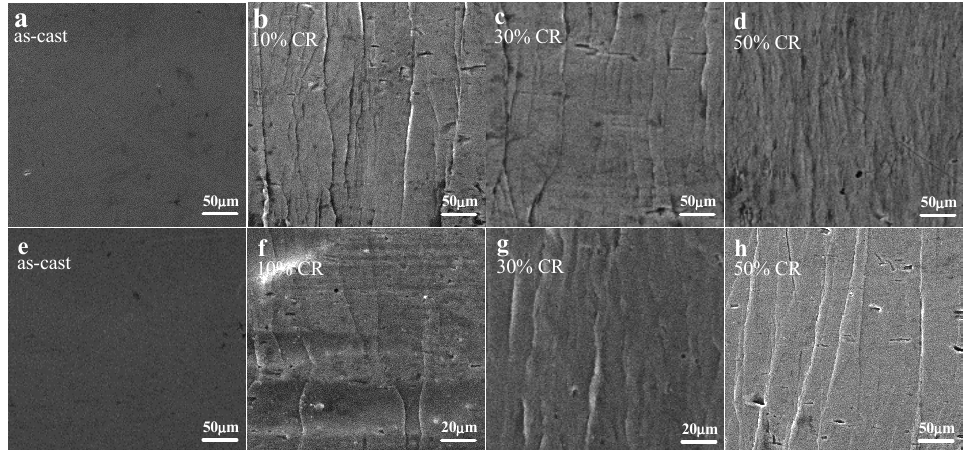
Figure 2. The SEM images for as-cast ( a , e ) and deformed A1 and A2 ribbons with 10% ( b , f ), 30% ( c , g ), and 50% ( d , h ) plastic strains.